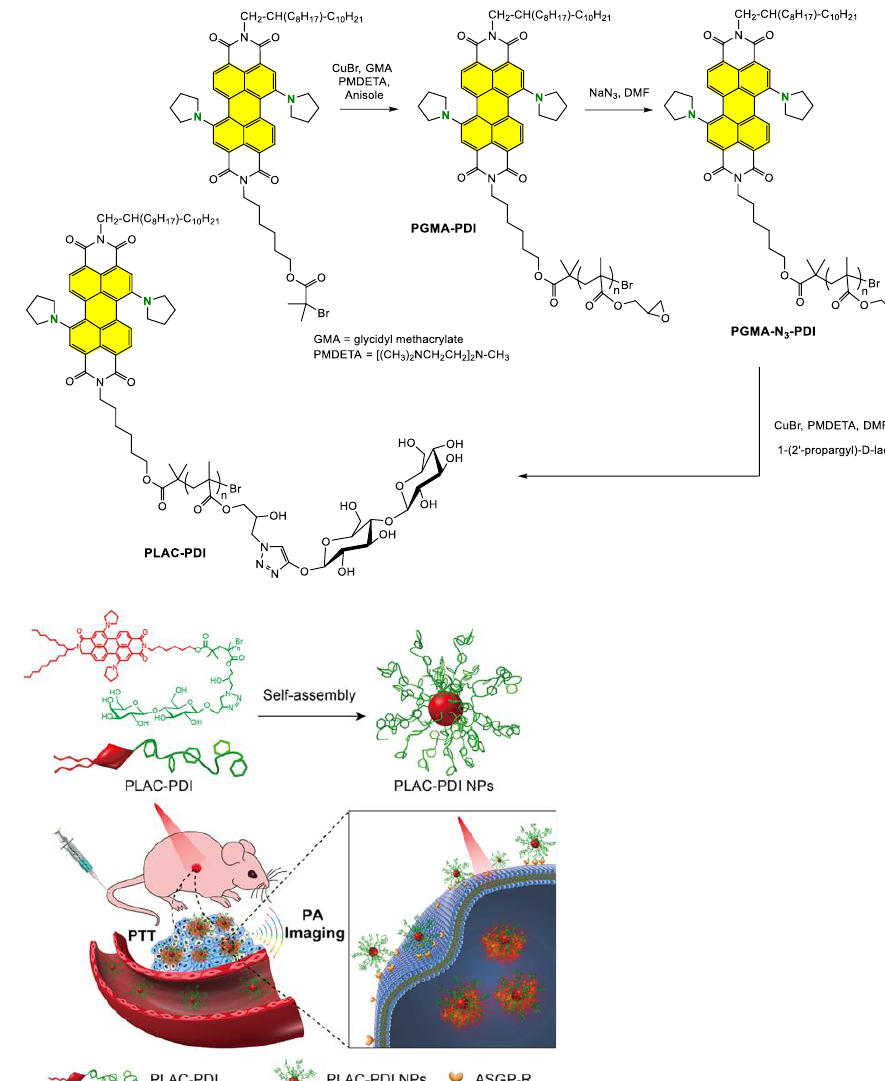
Figure 23. Synthesis of PLAC-PDI and illustration of the preparation of PLAC−PDI NPs and PAI/PTT applications to HepG2 tumours. Reprinted with permission from Ref. [134]. Copyright 2017 American Chemical Society.